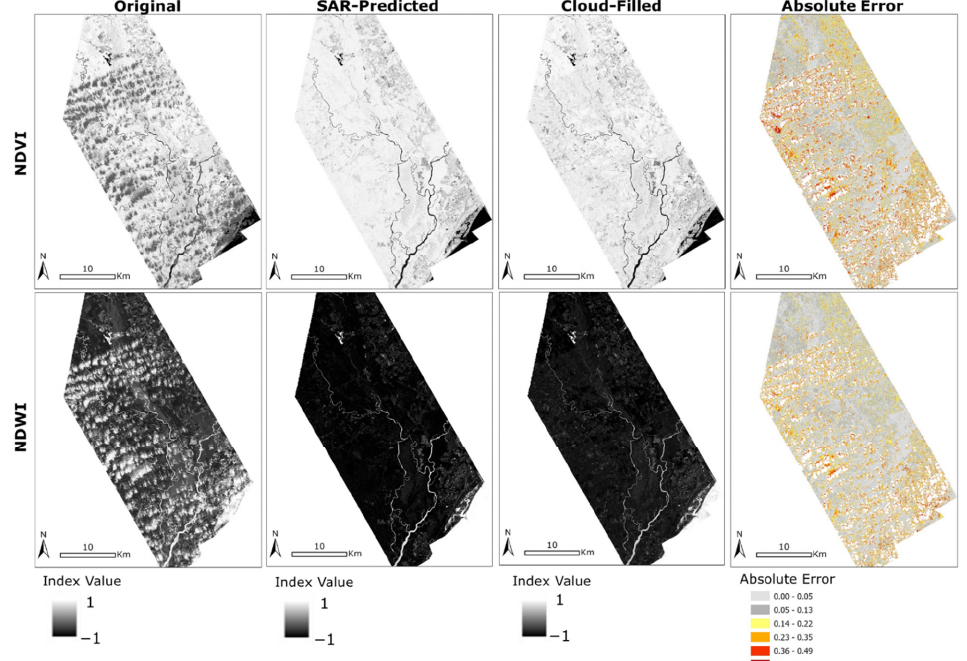
Figure 4. The original spectral indexes are shown for NDVI (top row) and NDWI (bottom row) with the model estimated pixel values (2nd column), combined multispectral and SAR-based cloud-filled indexes (3rd column) and the absolute error between the original spectral index and the SAR-predicted spectral index values computed per pixel. No data areas containing cloud or cloud shadow appear as white color in the absolute error map.